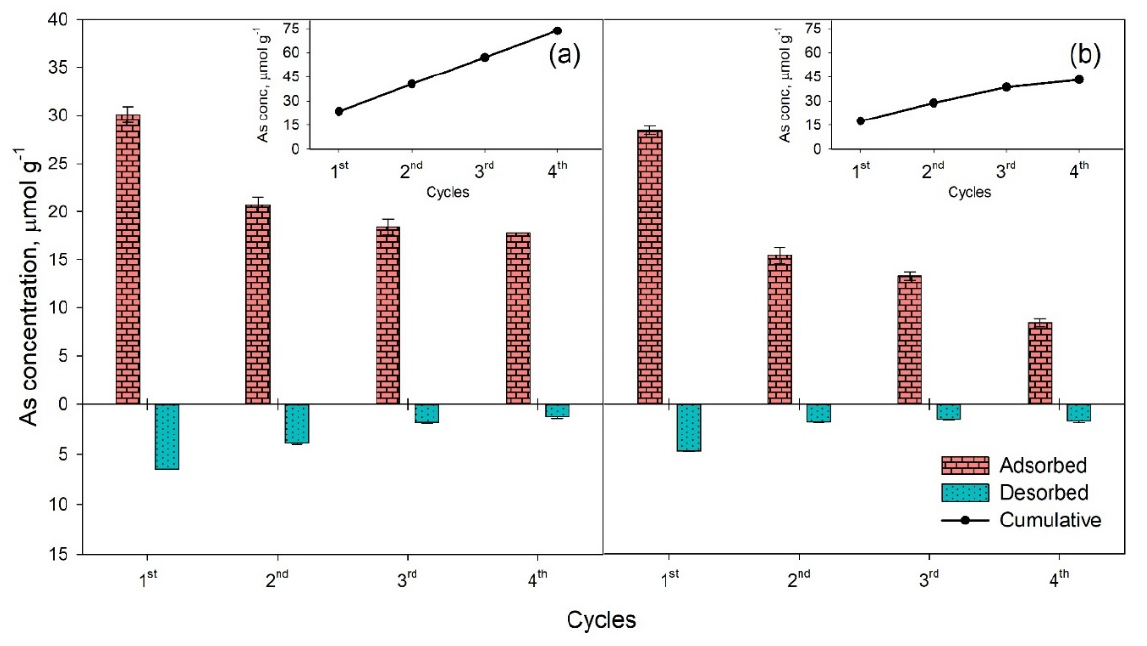
Figure 7. Concentrations of As(III) ( a ) and As(V) ( b ) adsorbed to and desorbed from the surface of Bi 2 O 3 (4 g L − 1 ) at pH 8 and 7, respectively and 25 ± 3 ◦ C in 4 cycles. The inlet graphs show the cumulative amounts of As bound to the adsorbent. Error bars represent standard